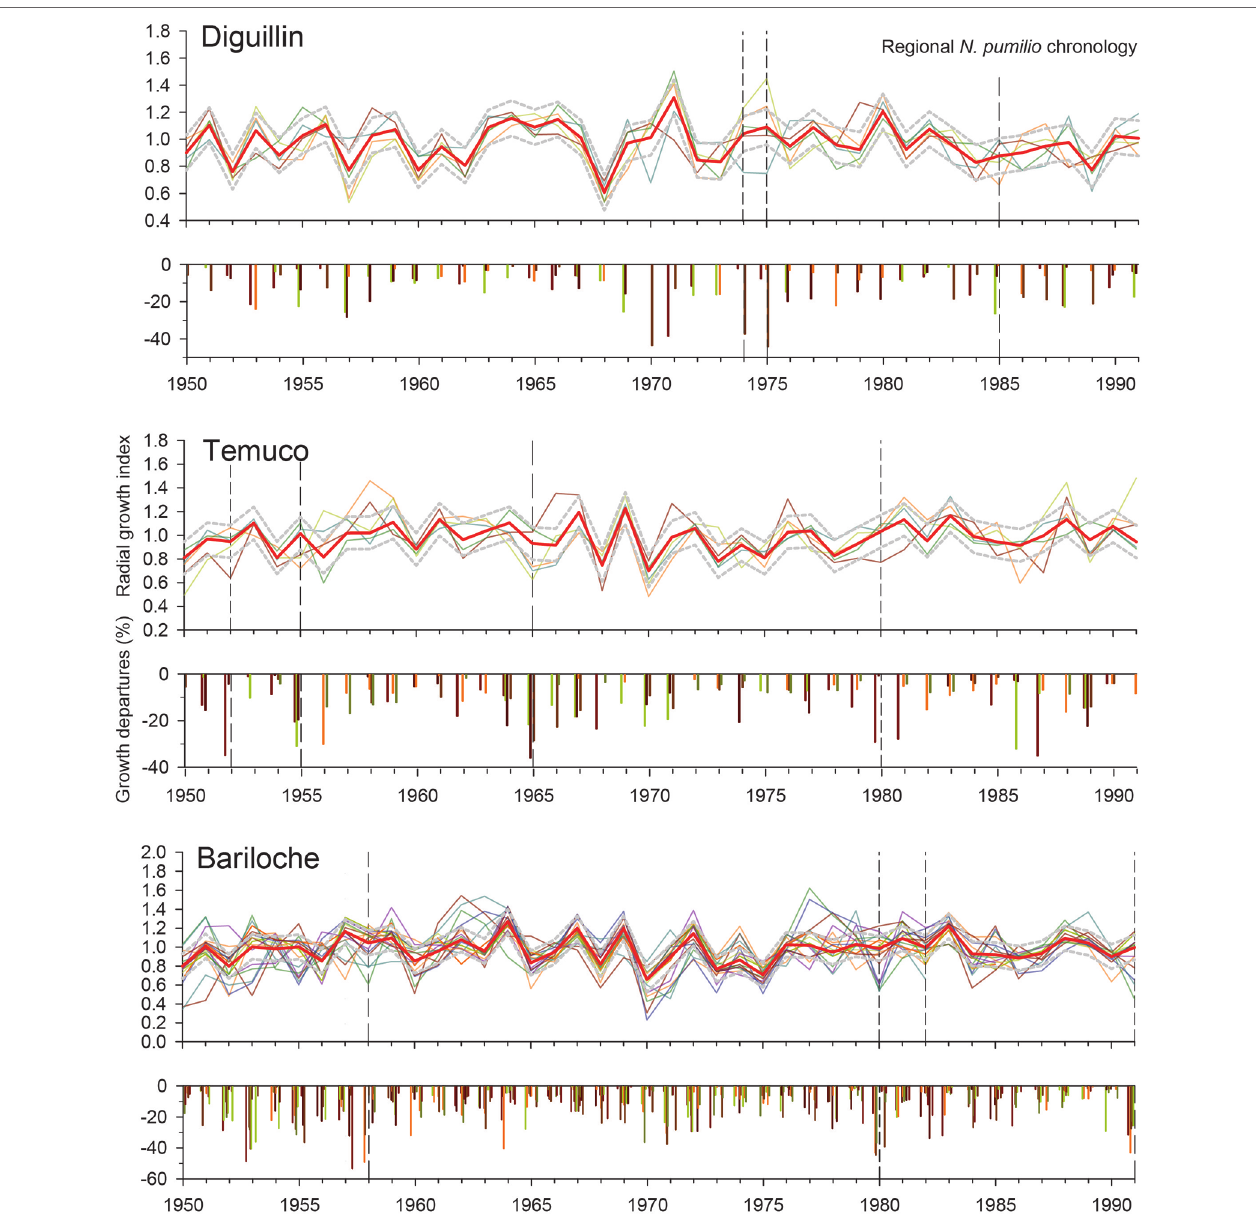
FIGURe 4 | Radial growth index in each stand (fine lines) and local growth reductions (vertical bars) for the three defined regions (Diguillin, Chilean north distribution; Temuco, Chilean west distribution, and Bariloche, Argentinean east distribution) related to the regional mean chronology (red lines). The upper and lower dotted grey lines indicate the SD limits. Vertical dotted lines indicate the reconstructed frost damage events with different uncertainty levels (see Table 1 ). Note that for this figure the regional chronology was performed using the set of all chronologies, while in the analysis the series from the target site were excluded to avoid redundant